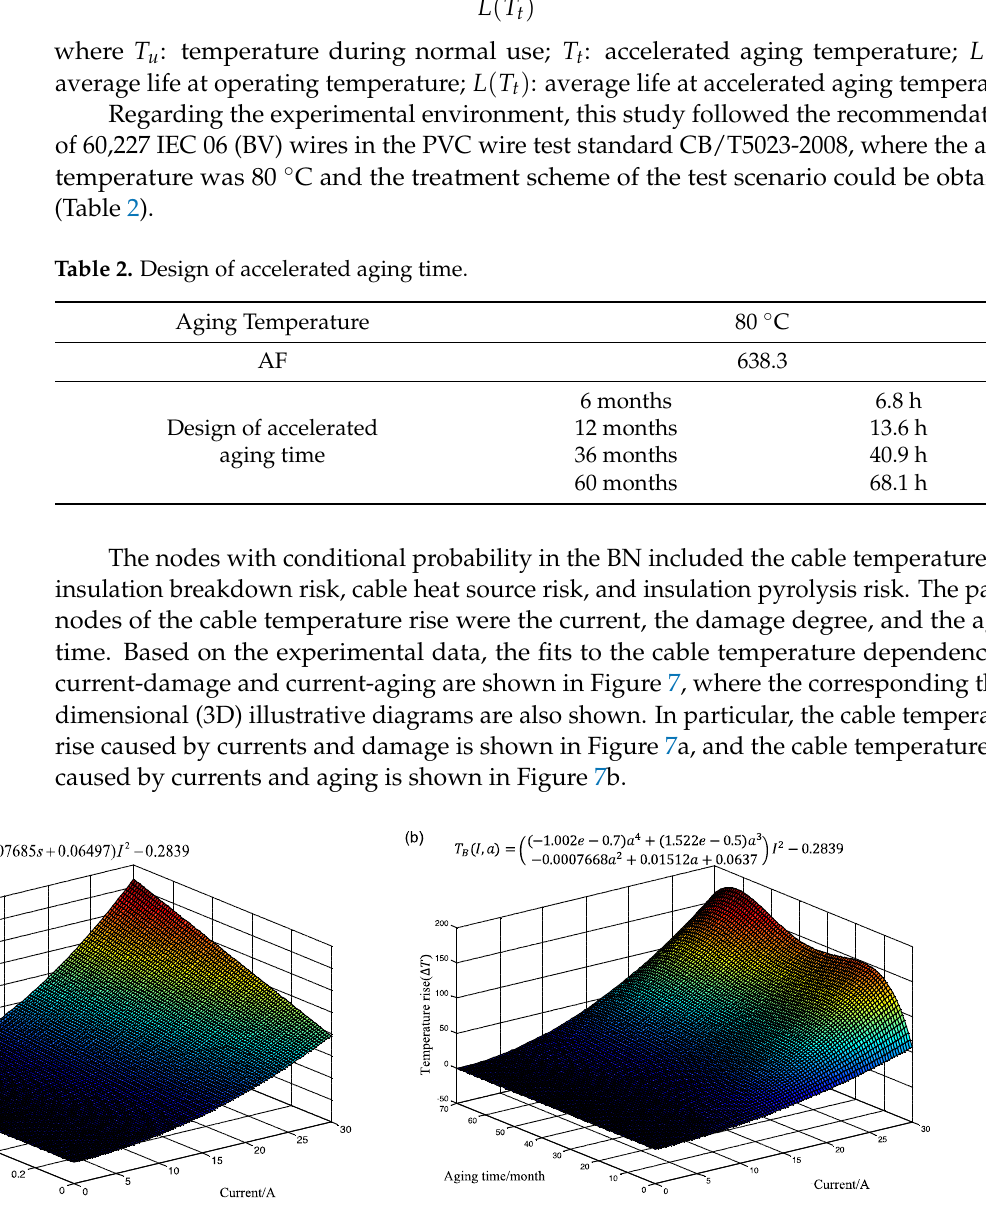
Figure 7. Fitted relationships: ( a ) current−damage; ( b ) current−aging.